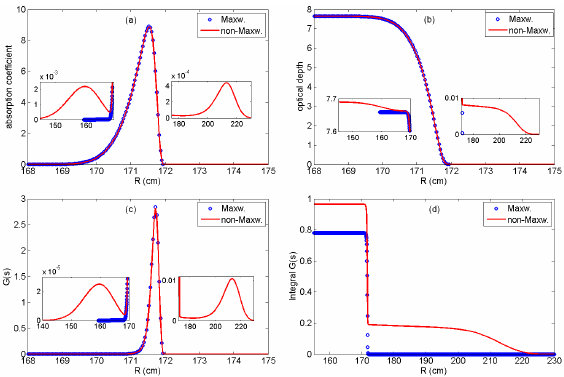
Figure 8. Example illustrating the spatial localization of 110 GHz ECE for plasmas (B 0 = 1 . 8 T @ 1.85 m) separately with Maxwellian and non-Maxwellian distribution functions: (a) absorption coe ffi cient α ( s ), (b) optical depth τ ( s ), (c) G ( s ) = (cid:82) ω 2 T rad ( s ) α ( s ) e − τ ( s ) , (d) G ( s ) ds . Here, s is along the major 8 π 3 c 2